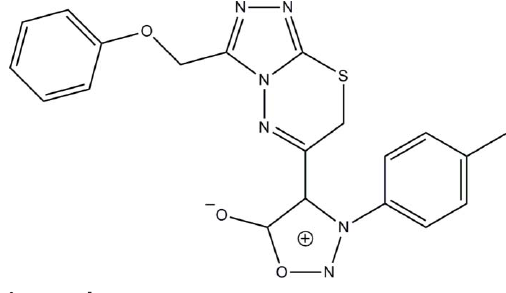
Bruker SMART APEXII CCD diffractometer